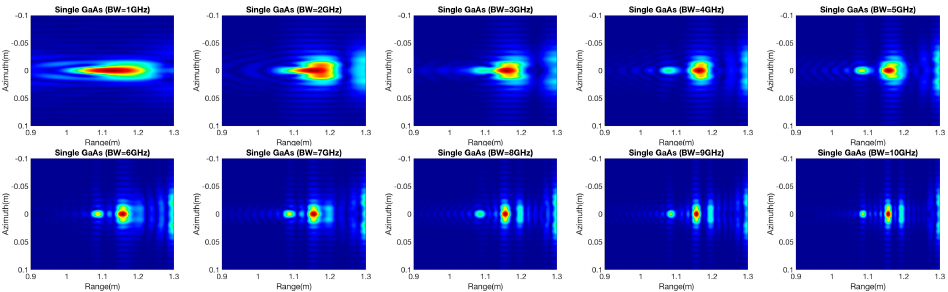
Figure 11. Images of a dielectric sphere with SAR bandwidth varying from 1 GHz to 10 GHz ( top : Teflon; middle : glazed ceramic; bottom : GaAs).